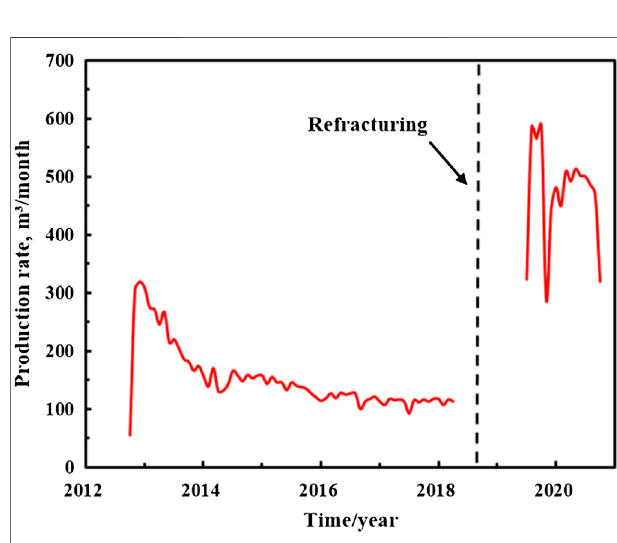
FIGURE 16 | Production variation law of a well before and after